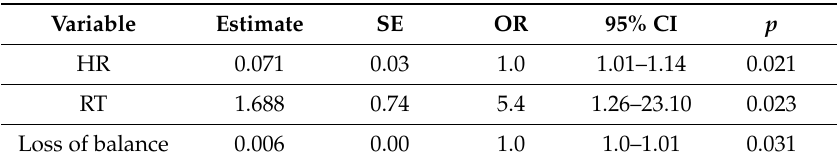
Table 5. Results of univariate regression analysis between clinical equine squamous glandular disease (ESGD, defined as horses with a squamous ulcer score ≥ 3 in any single location and / or a summed score ≥ 5 after transportation) as the binary outcome, loss of balance, changes in heart rate (HR) and changes in rectal temperature (RT) before and after transportation or confinement. Data were collected from confined (n = 12) and transported horses (n =